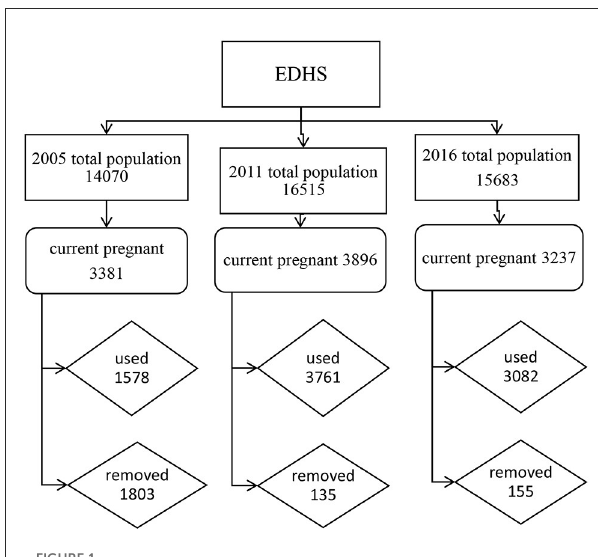
FIGURE1 Inclusion and exclusion of pregnant women in this